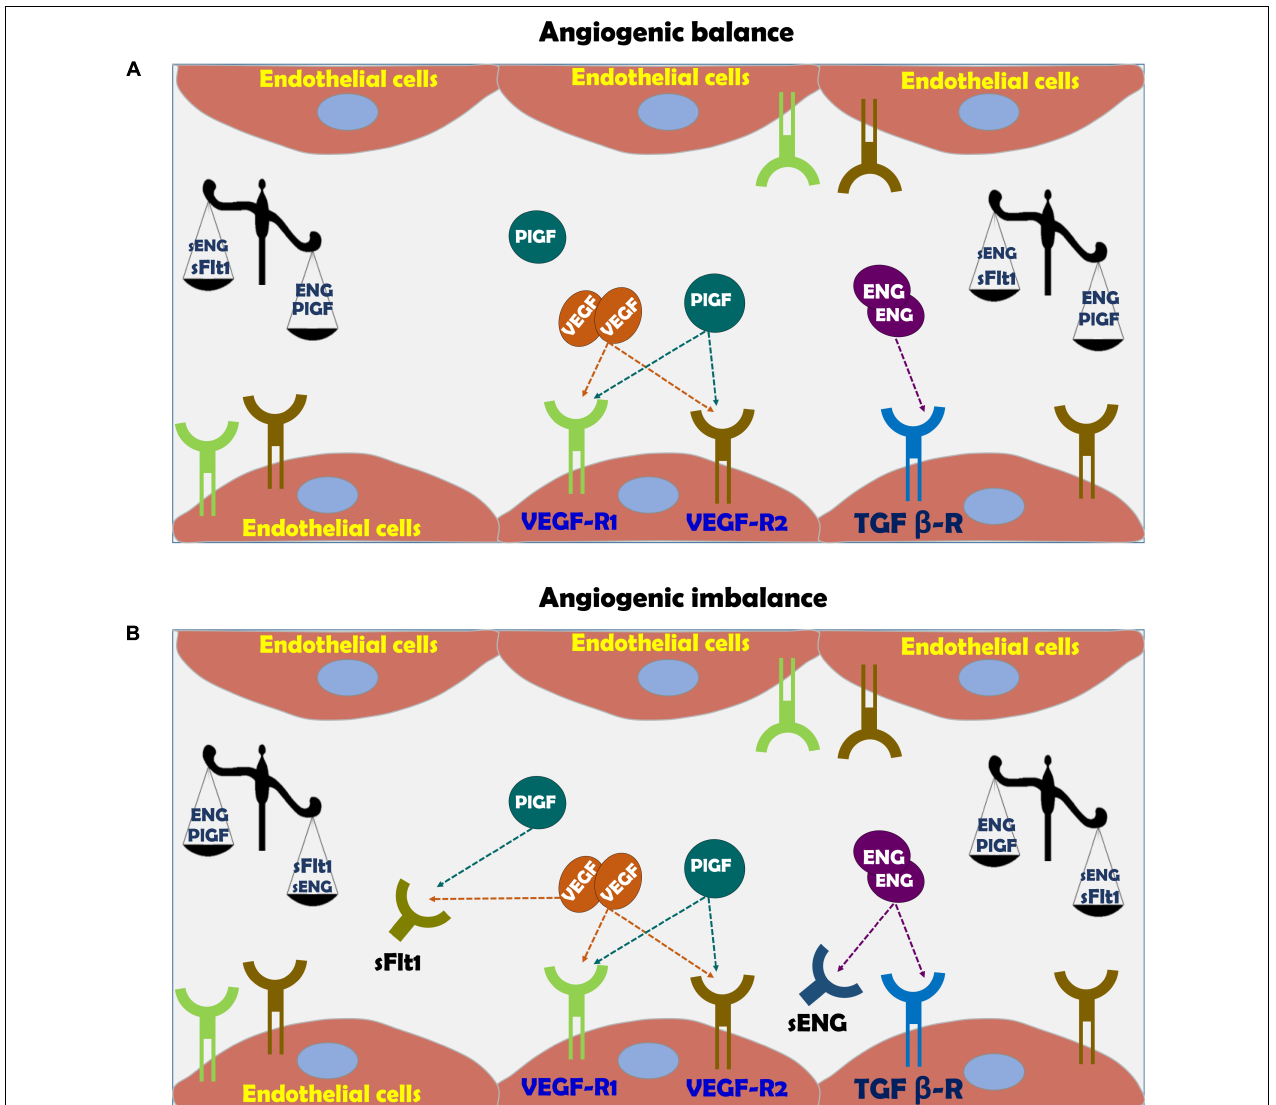
FIGURE 3 | (A) Vascular function in normal pregnancy and (B) Vascular dysfunction in preeclampsia. In normal pregnancy there is angiogenic balance as evident by VEGF, PlGF, and TGF- β levels, which are necessary for normal blood vessel formation and endothelial function via eNOS activation and subsequent nitric oxide generation. The action of these factors is hampered in preeclampsia due to angiogenic imbalance, where soluble sFlt-1 and sEng act as scavengers for native VEGF, PlGF, and TGF- β , thus inducing endothelial